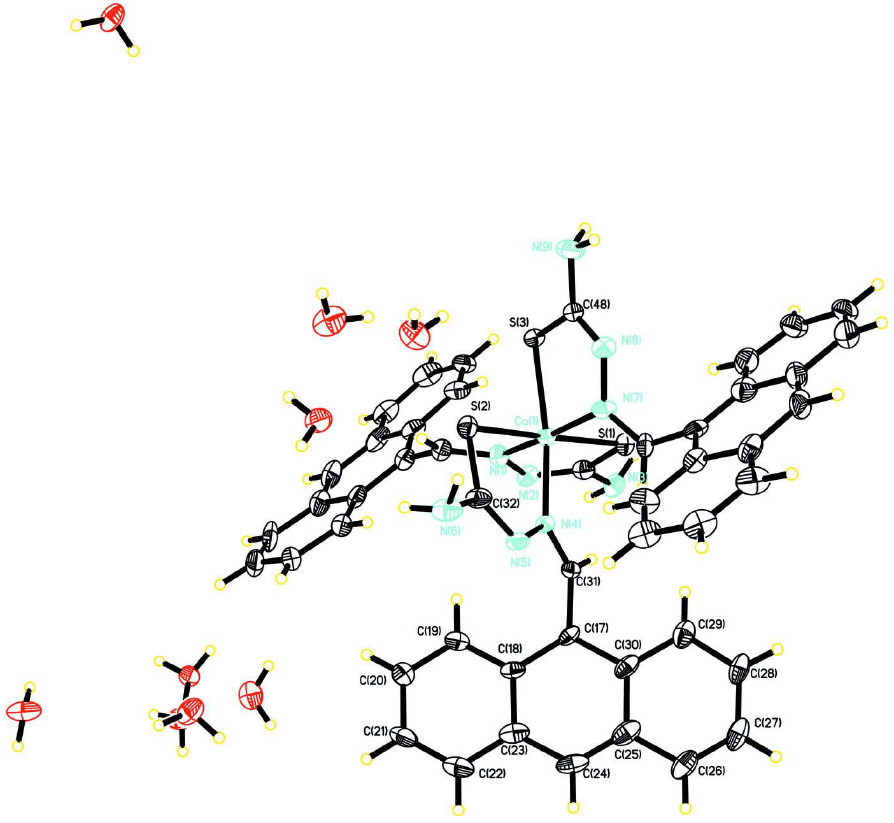
The molecular structure of (I), with atom labels and 30% probability displacement ellipsoids. H atoms have been omitted for